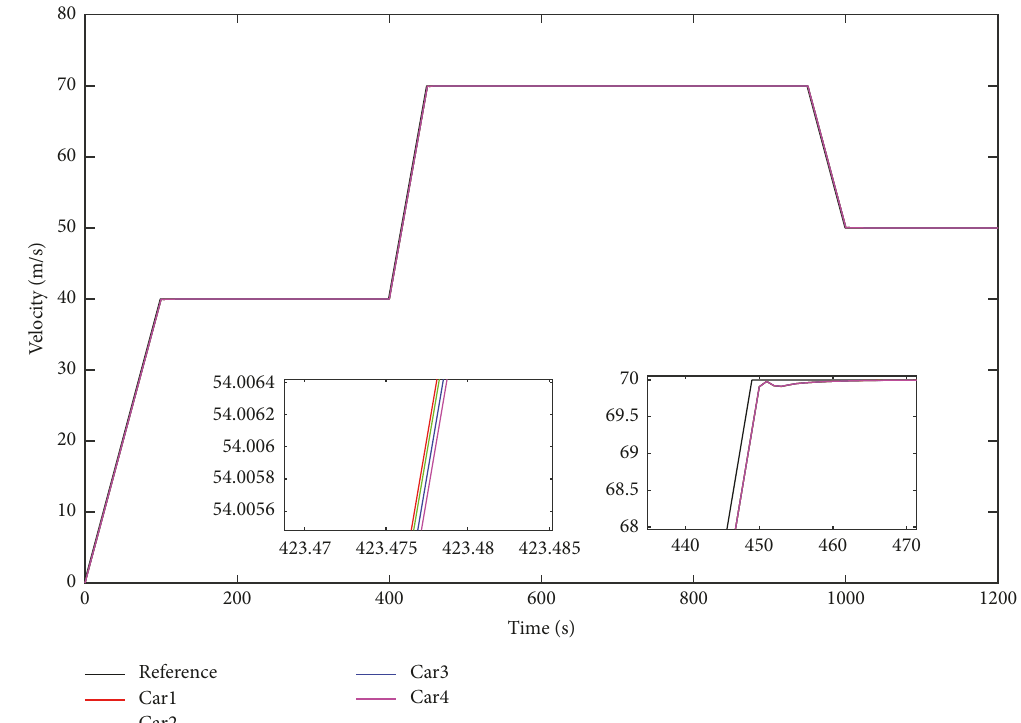
Figure 3: Speed curves for each car of high-speed train in the cruise phases.